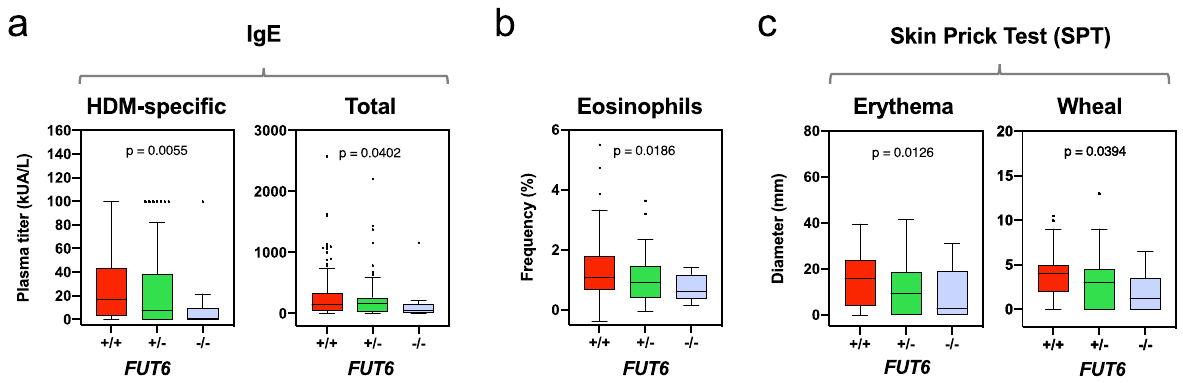
Fig. 8 Association of FUT6 null alleles to allergy-related parameters. Plots were generated with data from individuals of the SSIC cohort 21,22 . a IgE. The box and whisker plots, box representing the upper and lower quartile, central line representing the median, and the minimum and maximum values indicate the distribution of the plasma amounts of allergen-speci fi c IgE reactive to house dust mite (HDM) (left panel) and total IgE (right panel) in reference to the imputed FUT6 status ( + / + ( n = 124), + / − ( n = 84), − / − ( n = 14)). b Eosinophil frequency. The y -axis displays the frequency of eosinophils of the total leukocyte count. c Skin prick Test (SPT). The box and whisker plots, box representing the upper and lower quartile, central line representing the median, and the minimum and maximum values indicate the response of allergen-speci fi c skin prick tests. The parameters displayed are the diameter of the erythema (left panel) and the wheal (right panel) induced by HDM. In all experiments, the signi fi cance was determined by Kruskal – Wallis test. The nominal p values are indicated in the fi